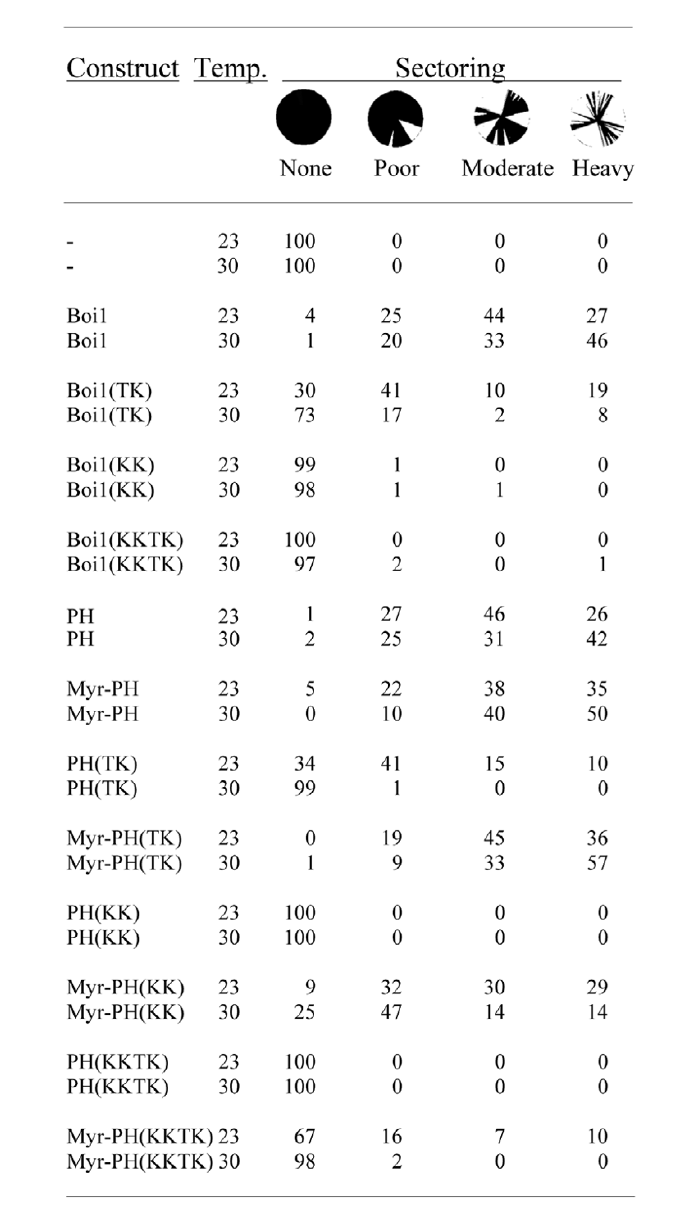
Figure 6 Colony-sectoring analysis to test the ability of different mutant versions of Boi1 and Boi1-PH to substitute in function for wild-type Boi1 and Boi2. Values are percentages of colonies that displayed each of the different degrees of sectoring: "none" = no sectoring (i.e., thoroughly red colony), "poor" = one or a few white sectors in an otherwise thoroughly red colony, "moderate" = more than a few white sectors, but where not more than approximately half of the colony contains sectors, and "heavy" = most or all of the colony contains white sectors. The circles illustrate these categories of sectoring, with black representing the red parts of colonies. In this analysis, boi1 boi2 strain PY967, which contains wild-type BOI1 and the color marker ADE3 on one plasmid (pPB799), was transformed with a second plasmid containing the indicated construct that was being tested for function. Transformation plates were incubated at 23 or 30 ° C, as indicated. The different sets of amino- acid substitutions are indicated in parentheses. "Boi1" = full-length Boi1; "PH" = Boi1-PH; and "Myr-" = fusion to the myristoyl group-accepting sequence MGCTVS. The constructs were encoded by the following plasmids: - (pPB1306), Boi1 (pPB2003), Boi1(TK) (pPB2008), Boi1(KK) (pPB2002), Boi1(KKTK) (pPB1671), PH (pPB1695), Myr-PH (pPB1498), PH(TK) (pPB1669), Myr-PH(TK) (pPB1667), PH(KK) (pPB1697), Myr-PH(KK) (pPB1500), PH(KKTK) (pPB1757), and Myr-PH(KKTK)